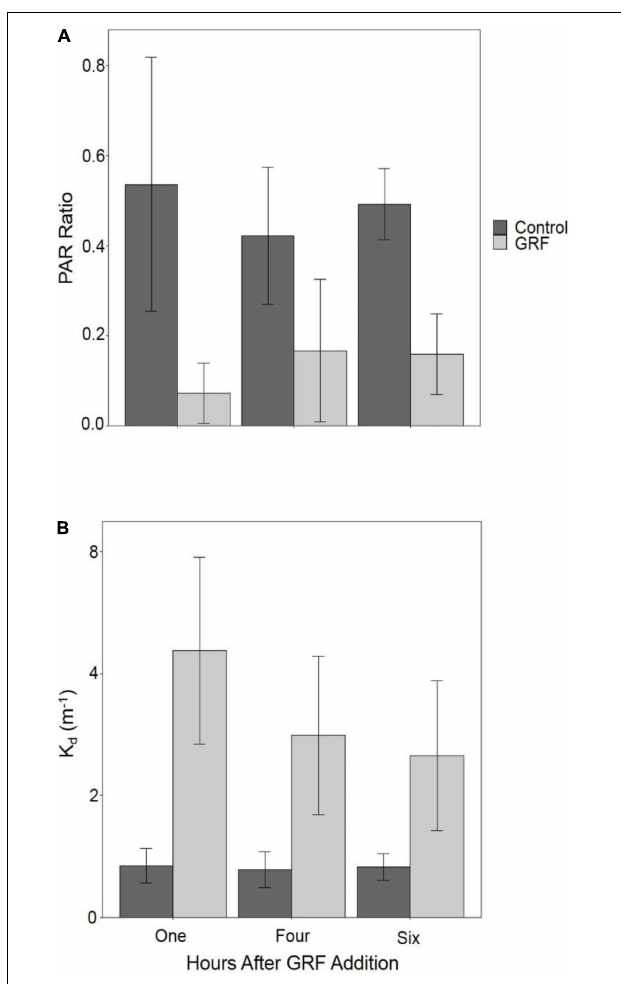
FIGURE 2 | Comparison of the light environment between tanks that received glacial rock flour (GRF) and tanks that did not receive GRF. PAR ratio (0.5 m water/air reading; (A) and vertical light attenuation coefficient (K d ; B ) were measured in all tanks after GRF was added to all ( n = 14) but the control tanks ( n = 3). Both the PAR ratio and K d were measured one hour after GRF addition every day of the experiment, 4 hours after addition on days 0, 5, 6, and 7, and 6 h after addition on day 4. The light ratio was determined by dividing photosynthetically active radiation (PAR) measurements made at 0.5 m depth by PAR measurements from above the water’s surface in the air. Among GRF tanks, the light ratio was significantly lower one hour after GRF addition than 4 (Kruskal–Wallis p < 0.0001, df = 2, χ 2 = 26.46) or 6 h (Kruskal–Wallis p = 0.0002, df = 2, χ 2 = 26.46), but not significantly different between 4 and 6 hours (Kruskal-Wallis p = 0.1709, df = 2, χ 2 = 26.46; Figure 2 ). K d was significantly higher one hour after GRF addition (Kruskal–Wallis p < 0.0001, df = 2, χ 2 = 37.10), but not 4 nor 6 hours after addition (Kruskal–Wallis p = 0.2347, df = 2, χ 2 = 37.10). For each time, the light ratio was significantly lower (Kruskal–Wallis p < 0.0001, df = 1, χ 2 = 75.99) in tanks that received GRF compared to control tanks that did not. For each time, K d was significantly higher (Kruskal–Wallis p < 0.0001, df = 1, χ 2 = 87.88) in tanks that received GRF compared to control tanks that did not.